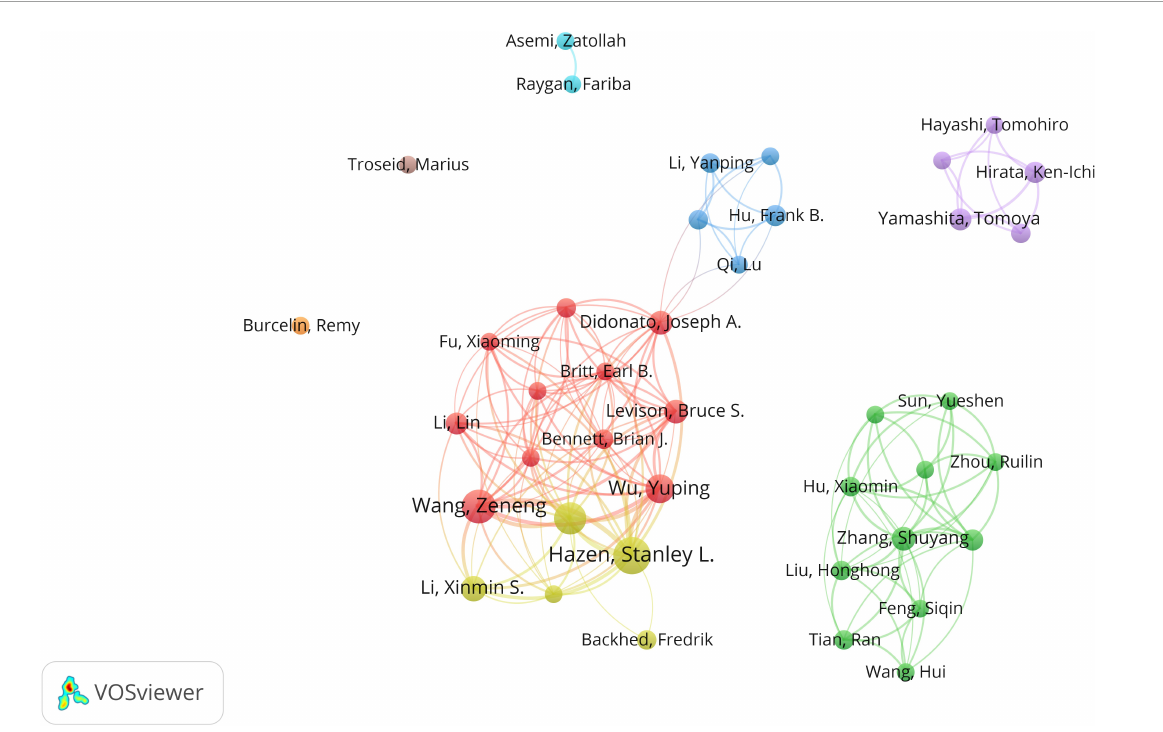
keywords with the highest frequency were presented in Table 5